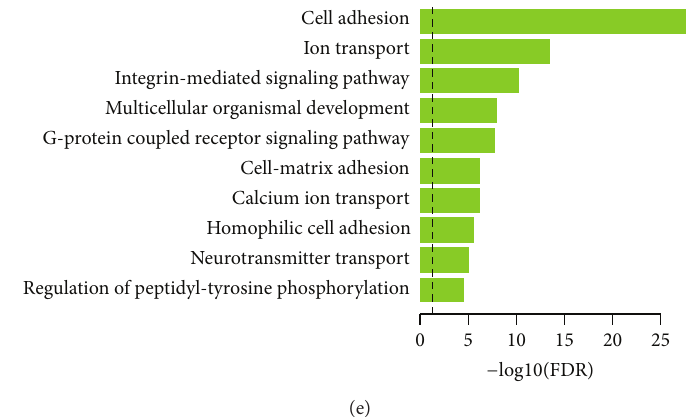
Figure 2: Transcriptome analysis of OCCs. (a) Principal component analysis of the transcriptome analyses of ovarian cell colonies (OCCs), neonatal ovaries, which served as starting material for OCC cultures, embryonic stem cells, and fibroblasts. The latter two served as reference samples. OCC transcriptomes differ from the neonatal ovaries’ transcriptomes. However, ovaries, ES cells, and OCCs are more similar among each other than to fibroblasts (see component 1, relative weight of 38.54%). (b) Top 50 differentially expressed genes between native neonatal ovary and OCCs. For gene bank and Ensembl identifiers, see Table 1 of Supplementary Material. (c) Top 50 differentially expressed genes between OCCs and fibroblasts. (d) Top 50 differentially expressed genes between OCCs and ES cells. (e) Gene ontology analysis of OCCs versus native ovary. Cell adhesion, ion and neurotransmitter transporters, and signaling pathways are predominantly upregulated in OCCs compared to the native